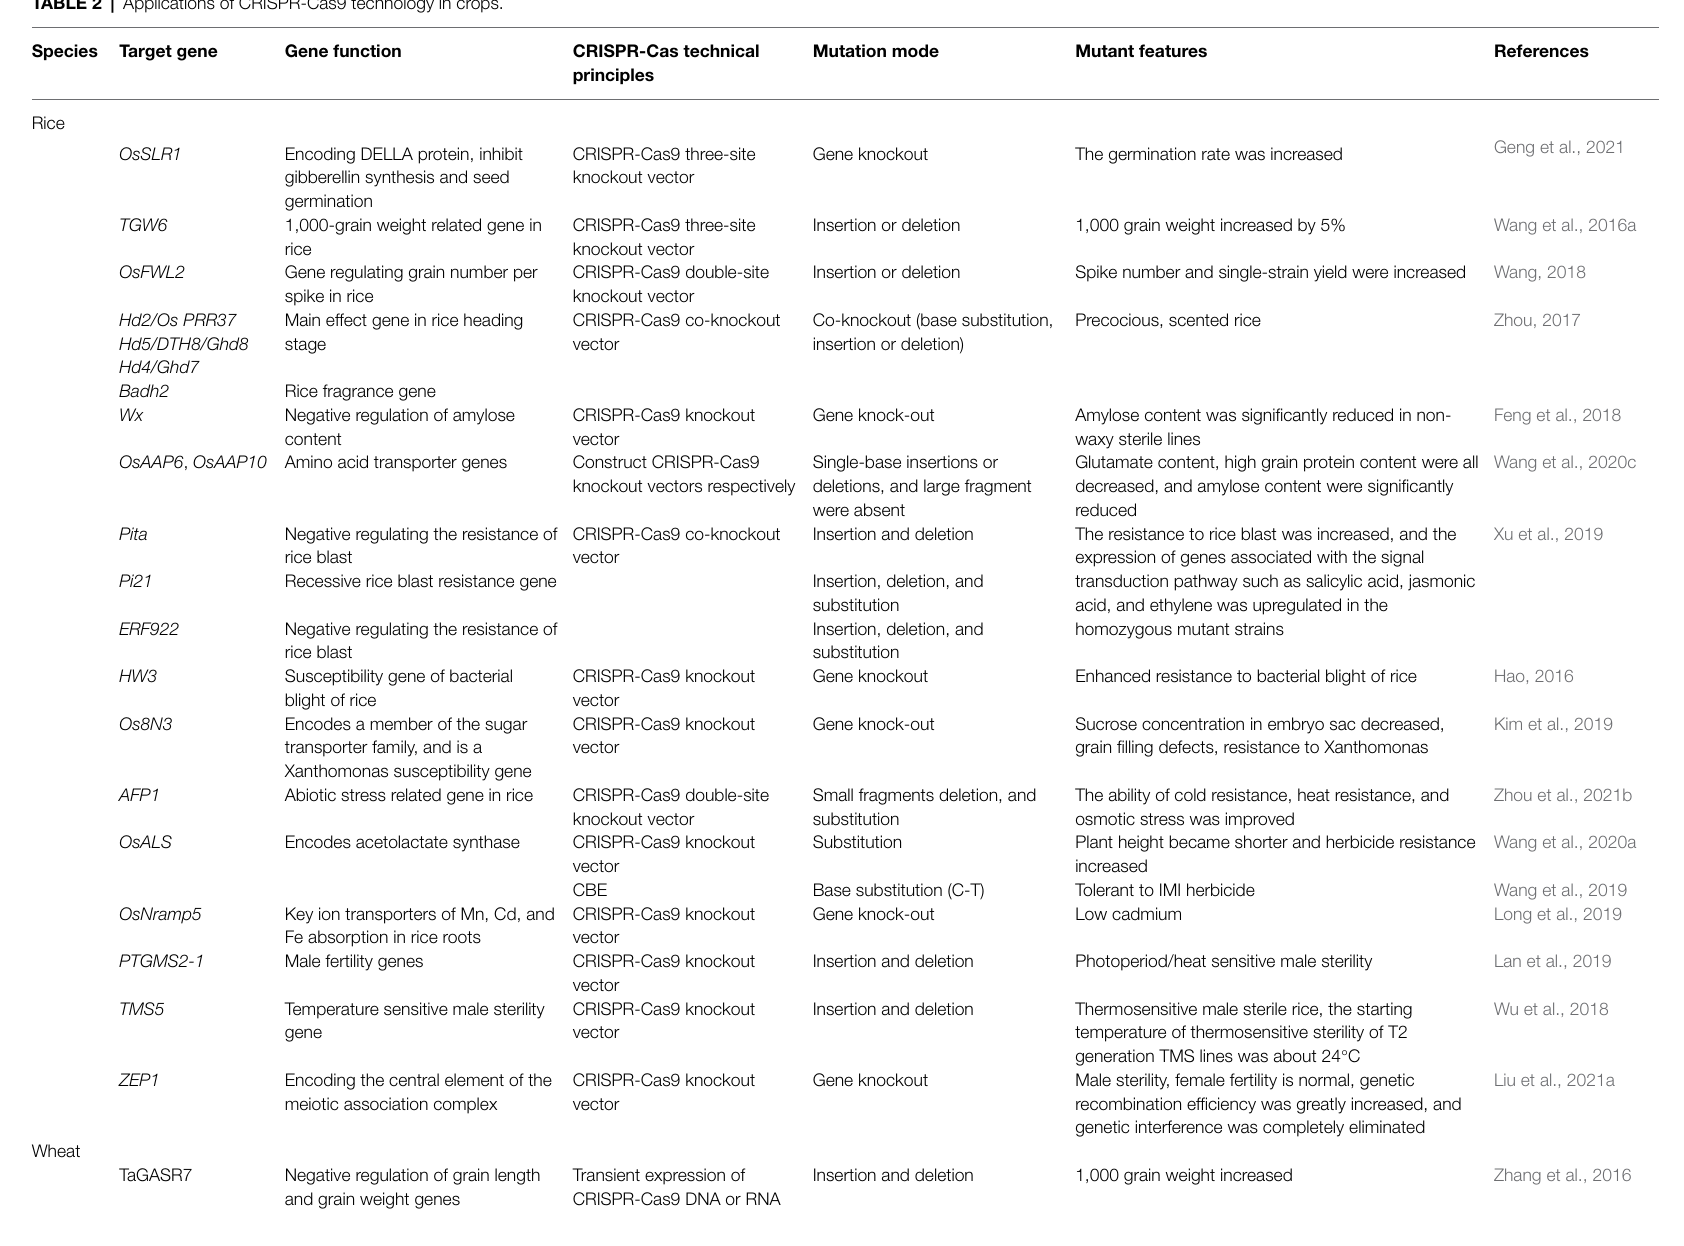
TABLE 2 | Applications of CRISPR-Cas9 technology in